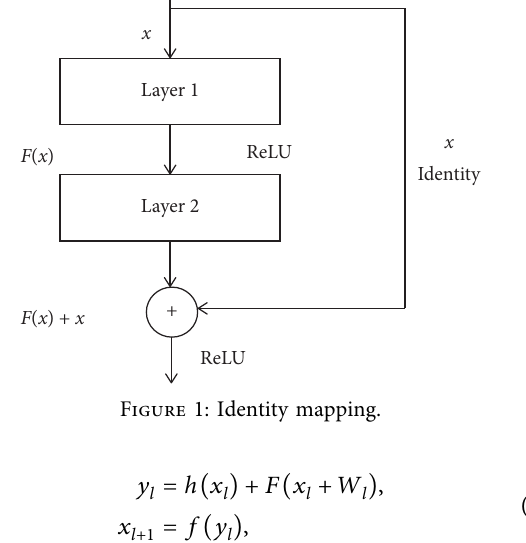
Figure 1: Identity